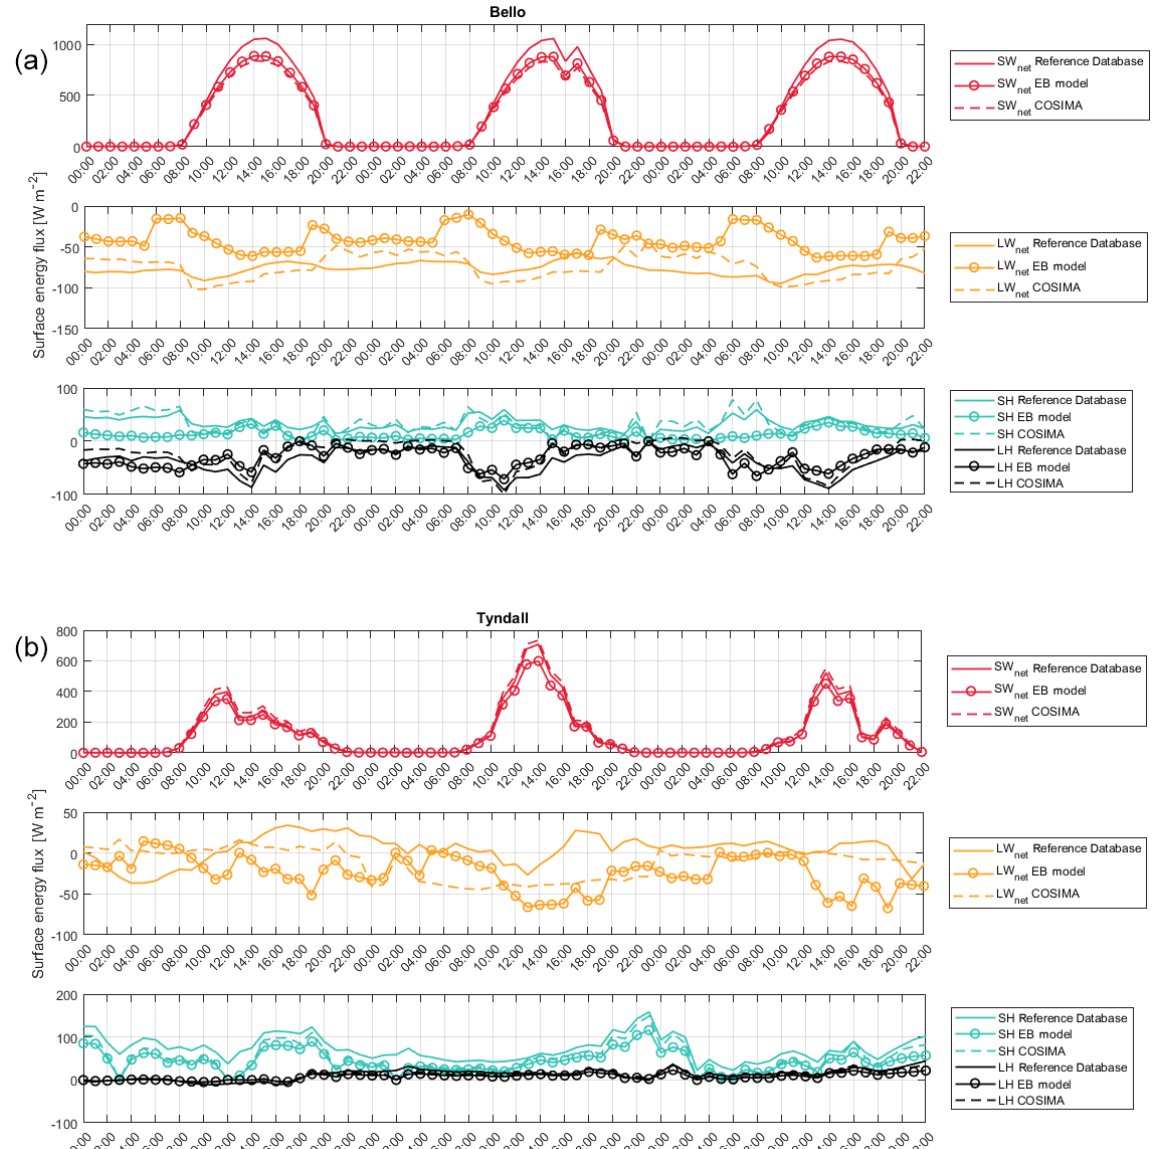
Figure A2. Comparison of modeled and measured hourly energy fluxes on glaciers Bello (a) and Tyndall 2016 (b) for the first 3d of February. Time is local